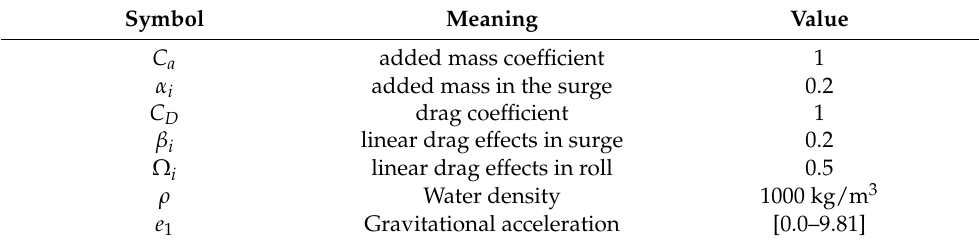
Table 2. Environment parameters.